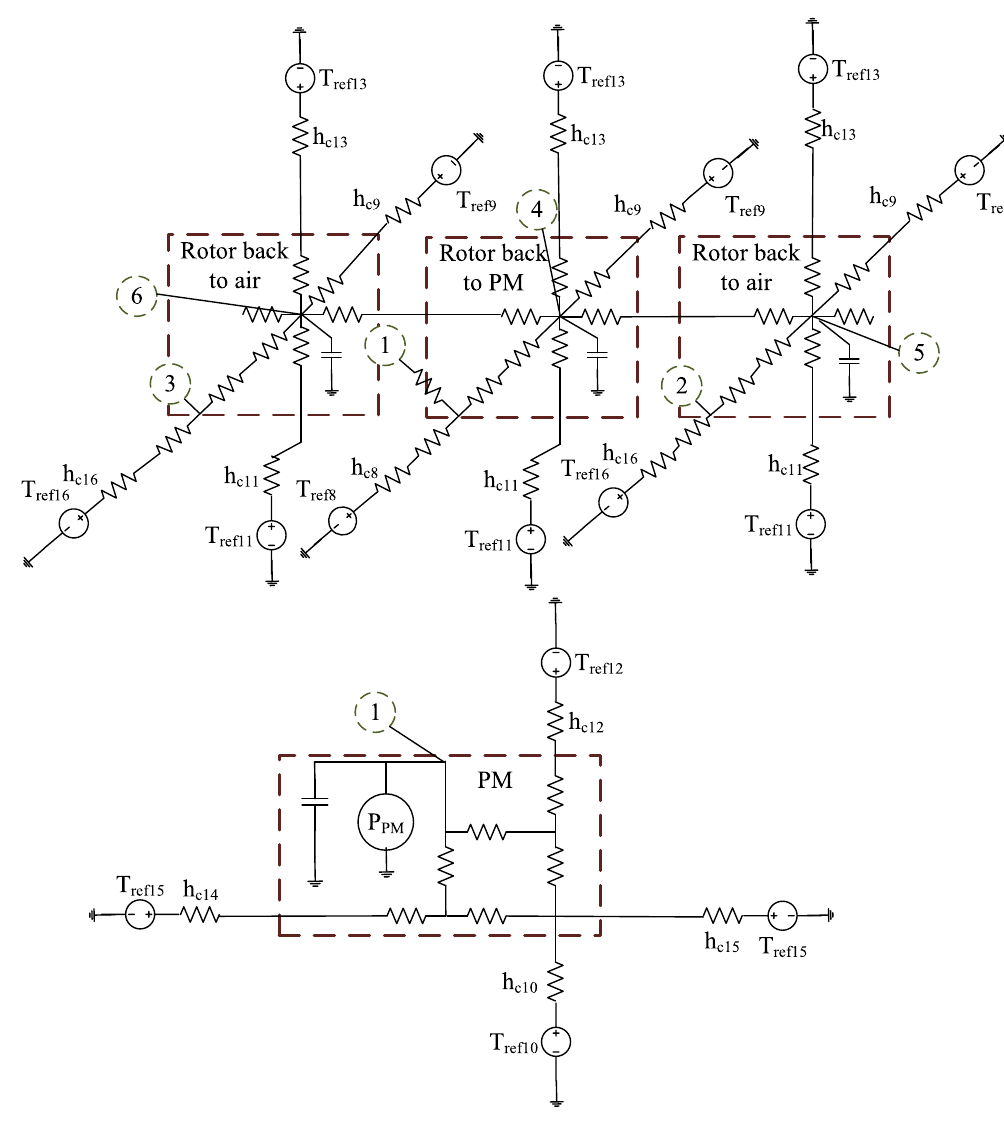
Figure 8. LPTN of the